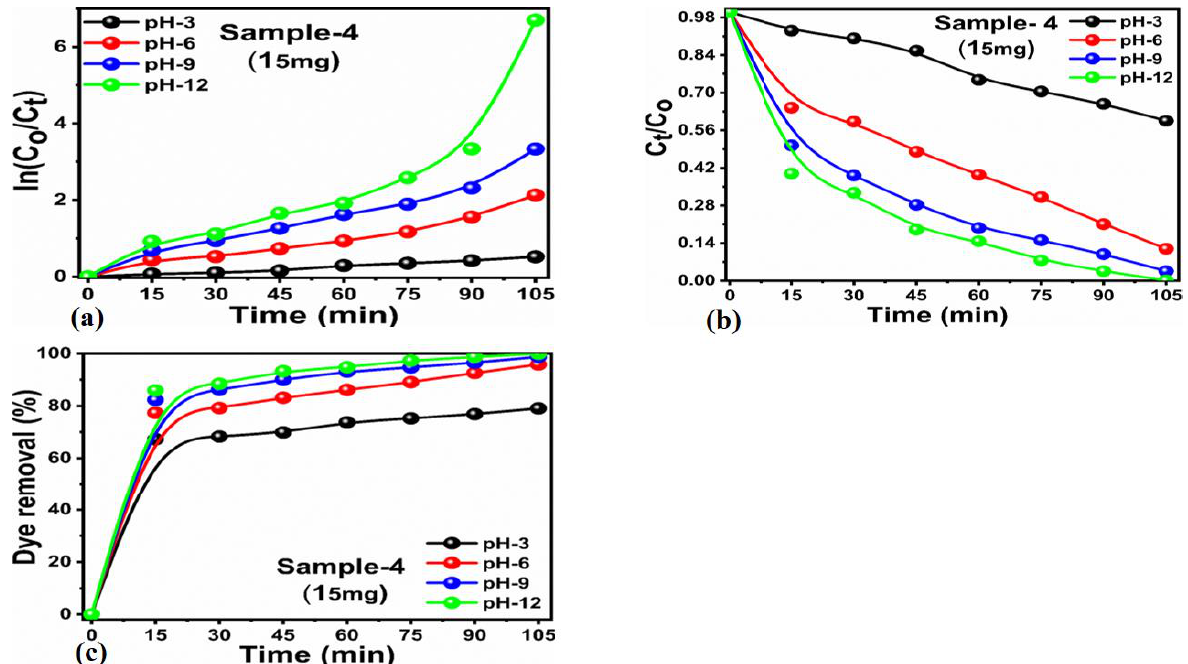
Figure 14. Various pH-dependent degradation kinetics of 6.12 × 10 −5 M MB solution using 15 mg catalyst dose of sample-4 under the irradiation of natural sunlight. ( a ) Linear plot of ln( C t / C o ) against corresponding time of 105 min. ( b ) Linear plot of C t / C o . ( c ) Various pH-dependent degradation efficiency of MB solution.